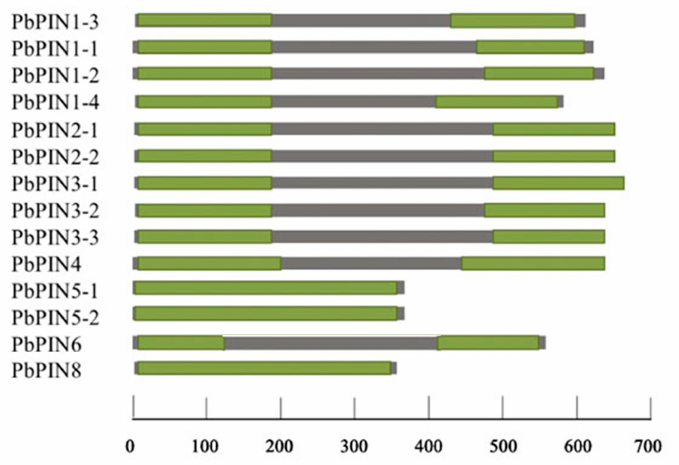
Figure 3. Structures of PbPINs in pear. The name of each corresponding protein is shown on the left. The green color indicates the position of the corresponding conserved domains: transmembrane domains (TMDs). The scale bar represents 100 amino acids.